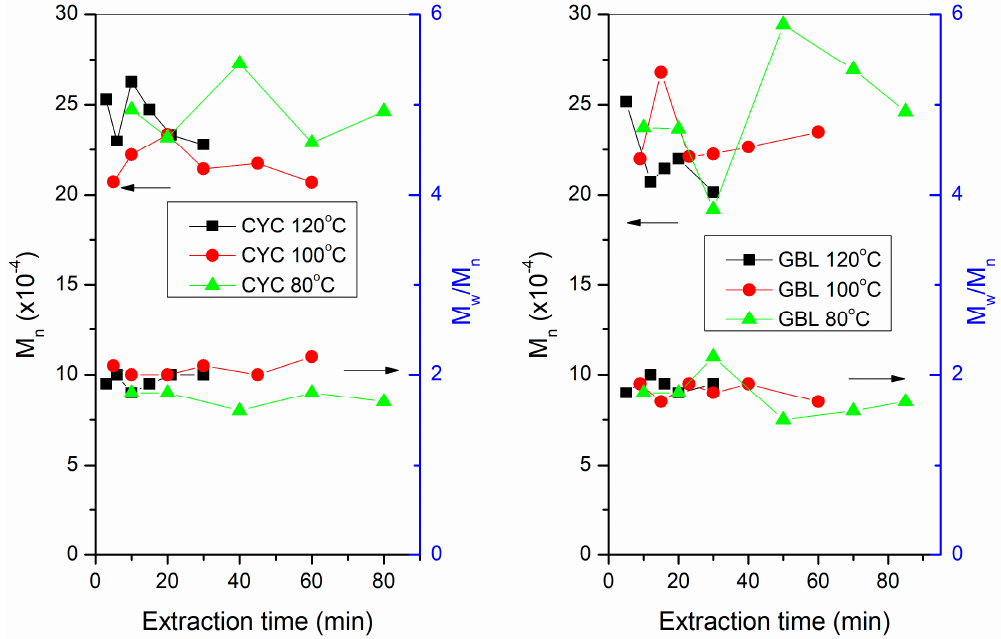
Figure 4. Effect of the extraction solvent cyclohexanone (CYC, left ) and γ -butyrolactone (GBL, right ) on molar mass ( M n ) and dispersity ( M w / M n ) of the extracted polymers at various temperatures versus extraction time.